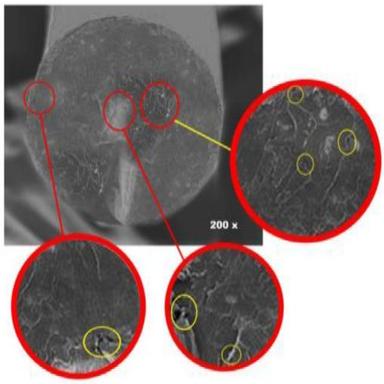
Micro voids within fiber and matrix filament.